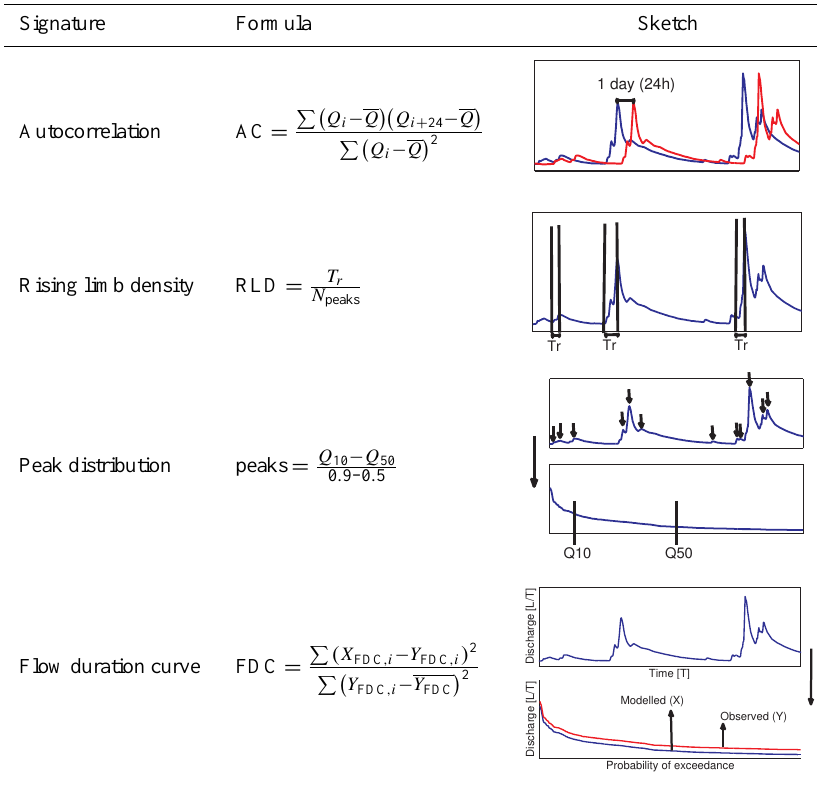
Table 1: Explanation of the different hydrological signatures used for this study. The formula for FDC directly gives the evaluation criterion. The formulas for AC, RLD and peaks only give the signature, the evaluation criterion can be derived with Equation 1 ( Q i is the discharge at time step i, Q is the average discharge, X FDC,i is the value of the flow duration curve of the modelled discharge with i probability of exceedance, Y FDC,i is the value of the flow duration curve of the observed discharge with i probability of exceedance, Y FDC is the average observed discharge).